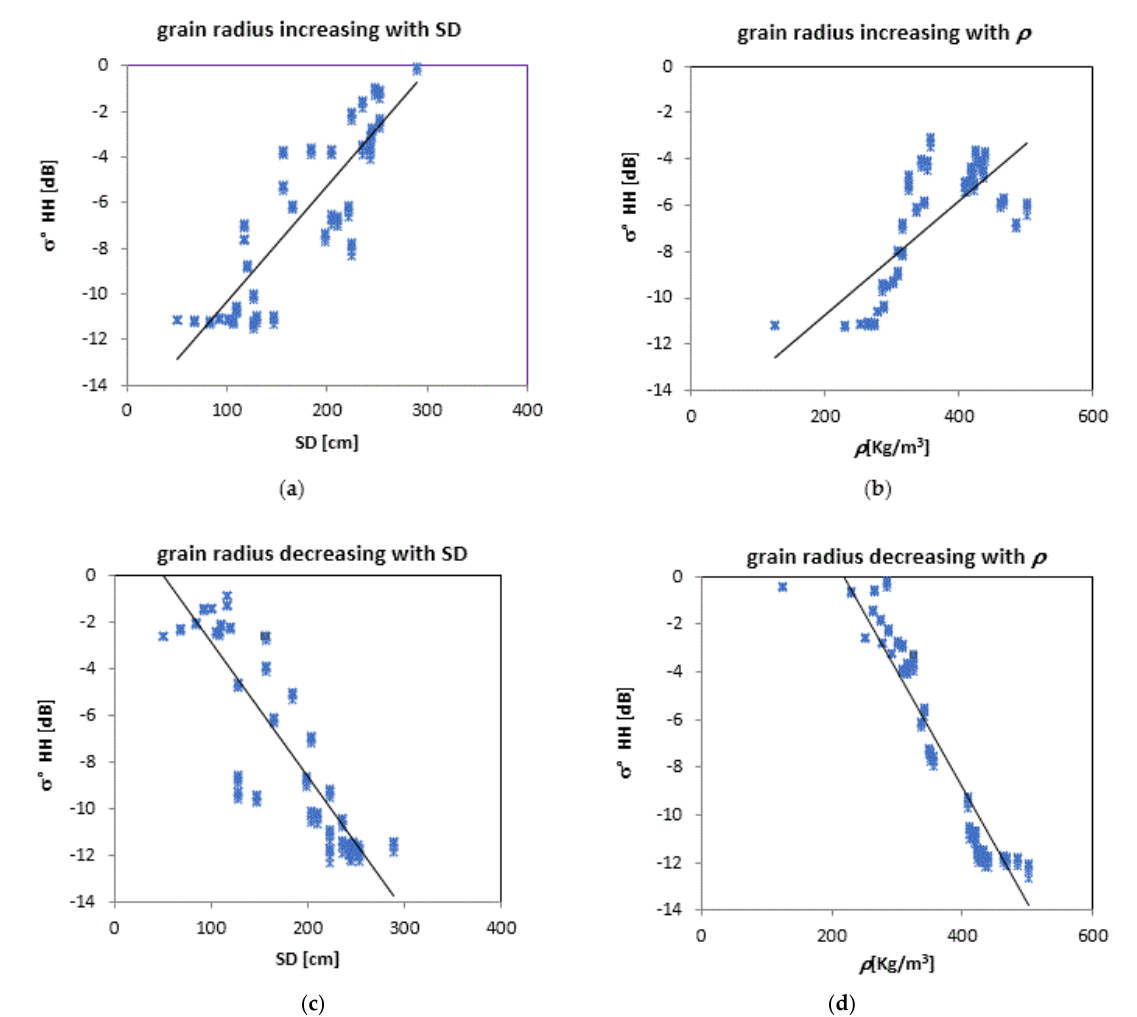
Figure 8.  ° (HH pol.) as a function of SD and  obtained by assuming a grain radius, r , increasing or Figure 8. σ ◦ (HH pol.) as a function of SD and ρ obtained by assuming a grain radius, r , increasing or decreasing with SD ( a , c ) and  ( b , d ), respectively. decreasing with SD ( a , c ) and ρ ( b , d ),